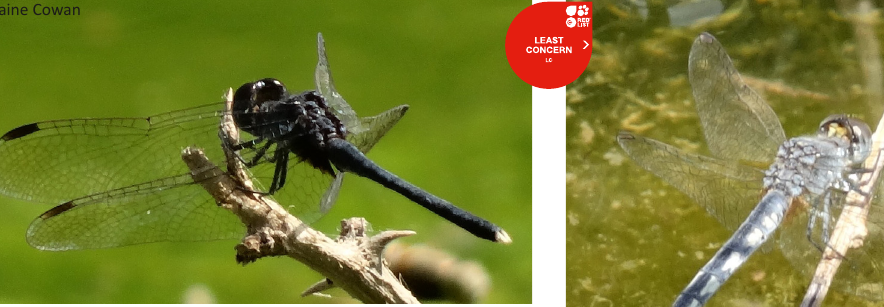
Image 22. Older mature male Diplacodes lefebvrii , 7 October 2013. Black abdomen. White terminal abdominal appendages